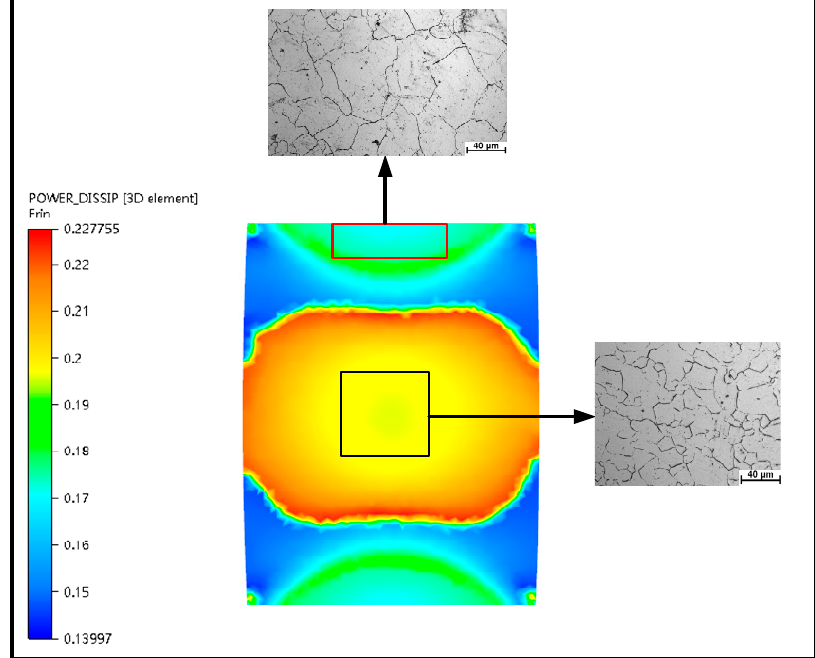
Figure 19. Characteristic diagram of thermal deformation power dissipation at 1050 °C/0.1/0.1 s − 1 .